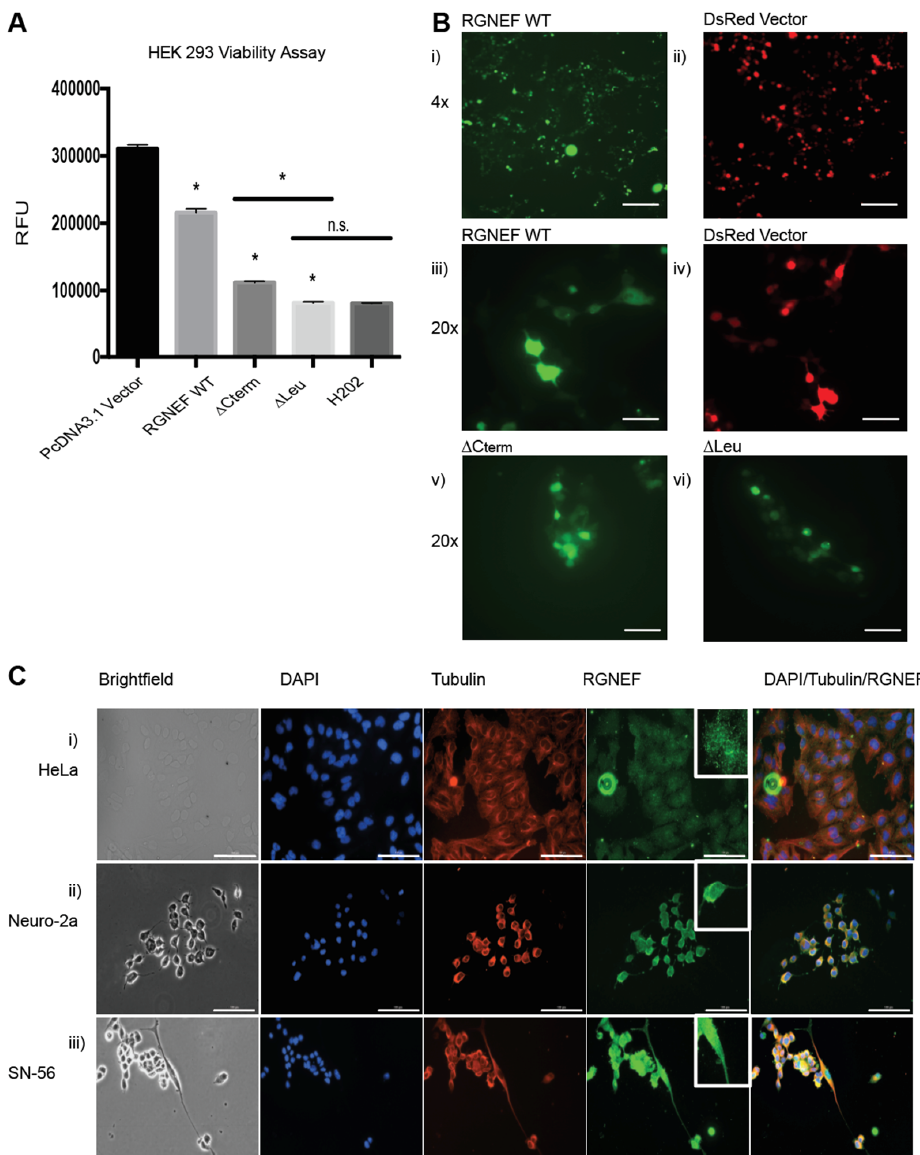
Figure 4. RGNEF toxicity and localization in mammalian cells. ( A ) Transfection of HEK 293 cells with DsRED control and RGNEF WT, ∆Cterm, and ∆Leu constructs. Following transfection, cell viability was measured by luciferase assay and quantified. * indicates statistical significance ( p < 0.05) and n.s. indicates not statistically significant compared to control. ( B ) Fluorescence microscopy of GFP-tagged RGNEF constructs transfected into HEK 293, (i) full length wild type RGNEF and (ii) DsRed vector control (4× magnification, scale bar = 500 μm), (iii) RGNEF WT (iv) DsRed expressing vector control, ∆Cterm overexpression and (vi) ∆Leu overexpression (20× magnification, scale bar = 100 μm). ( C ) Endogenous RGNEF localization is monitored by immunofluorescence microscopy in HeLa (i), Neuro-2a (ii), and SN-56 cells (iii) by immune fluorescence microscopy (20× magnification, scale bar = 100 μm). Error bars represent standard deviations.